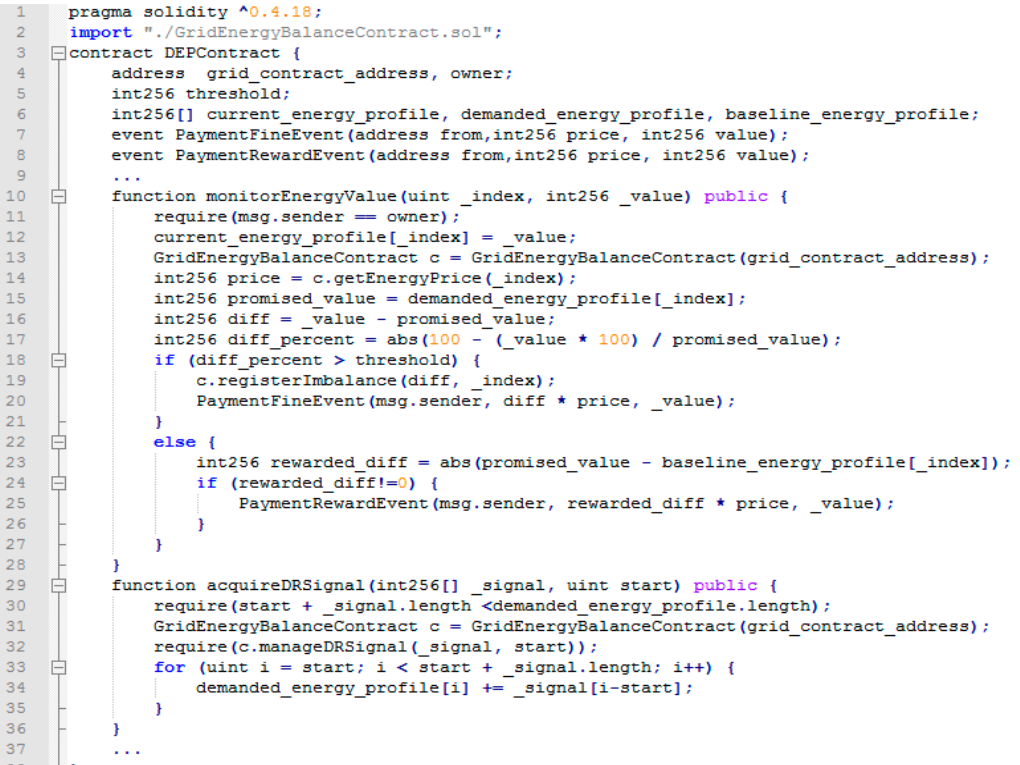
Figure 7. Code excerpt from the smart contract managing DEP energy profile.